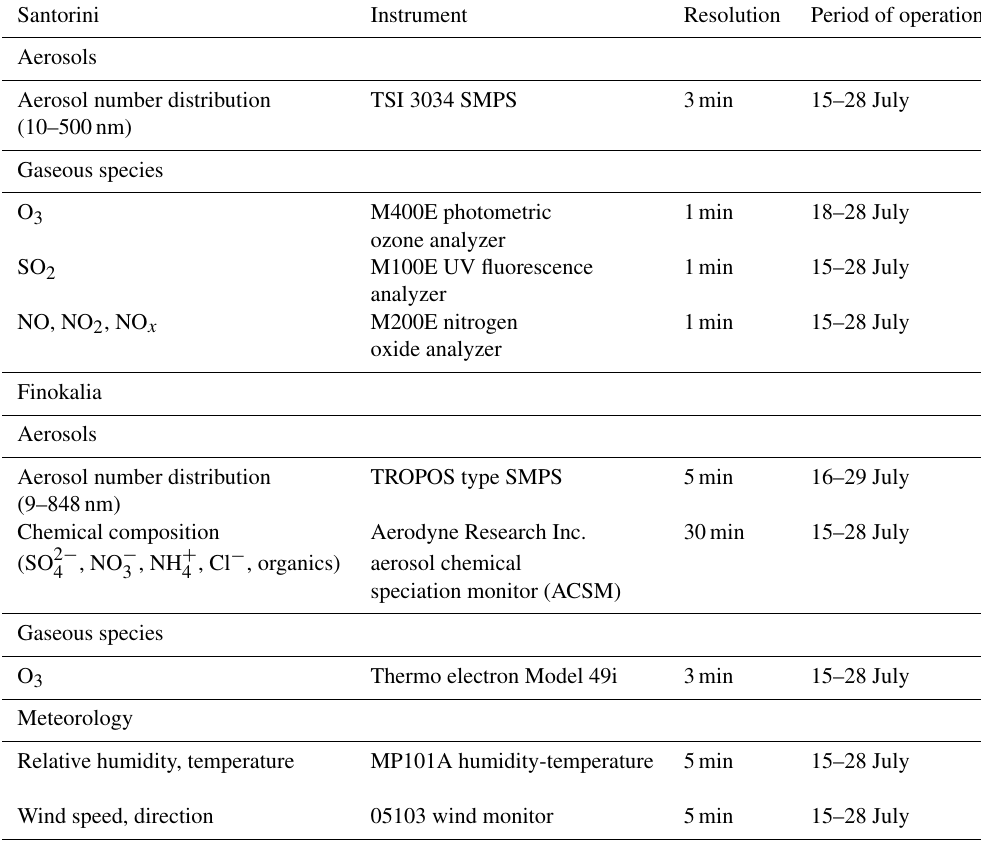
Table 1. Summary of the variables and operation characteristics of the instruments at Santorini and Finokalia stations. Santorini Instrument